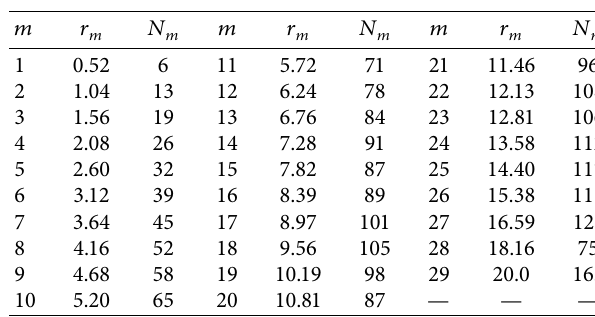
Table 2: Results of ring radii ( r for the UECRA including 2256 elements.